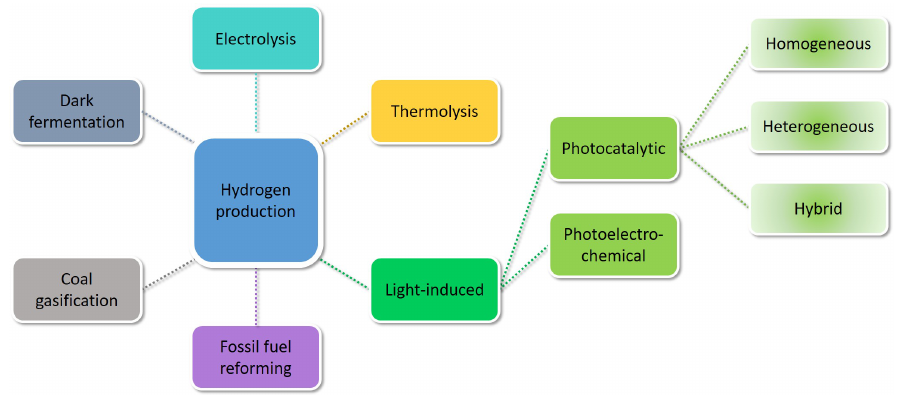
Figure 1. Most used possible routes for hydrogen generation. Currently, the solar-induced hy- drogen evolution from water splitting is the most promising approach among others since it is environmentally benign, cost-effective, and offers the potential for high conversion